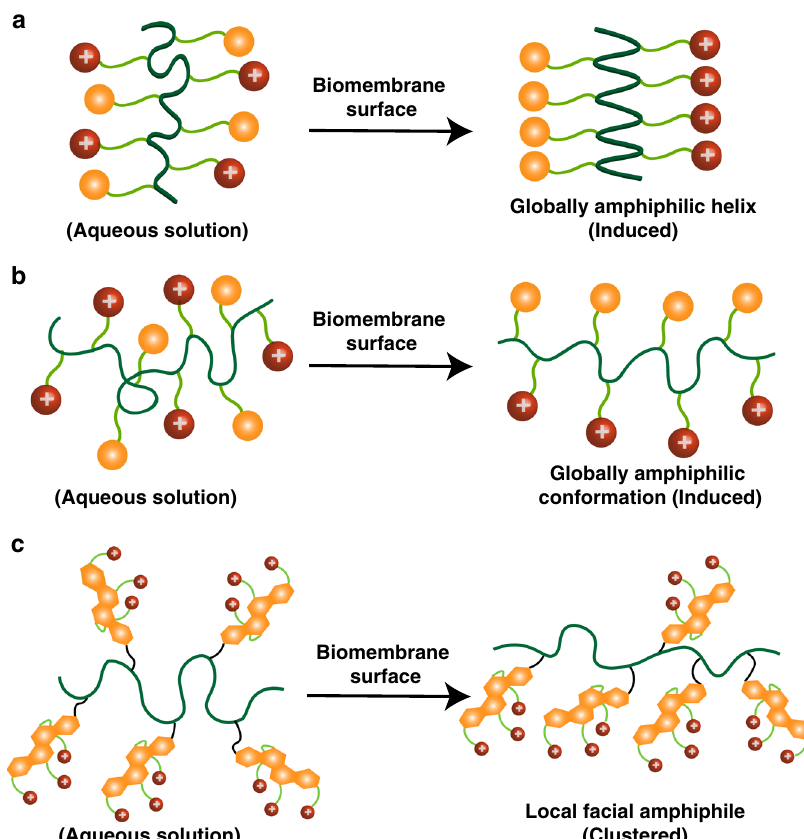
Fig. 1 Modes of action adopted upon approaching to a biomembrane surface. a Host-defense peptides adopting a globally amphiphilic helical conformation 36 ; b Synthetic antimicrobial polymers adopting a globally amphiphilic conformation; and c A fl exible macromolecular chain clustering intrinsic local facial amphiphiles (this work). Red color: cationic/hydrophilic groups, yellow color: hydrophobic